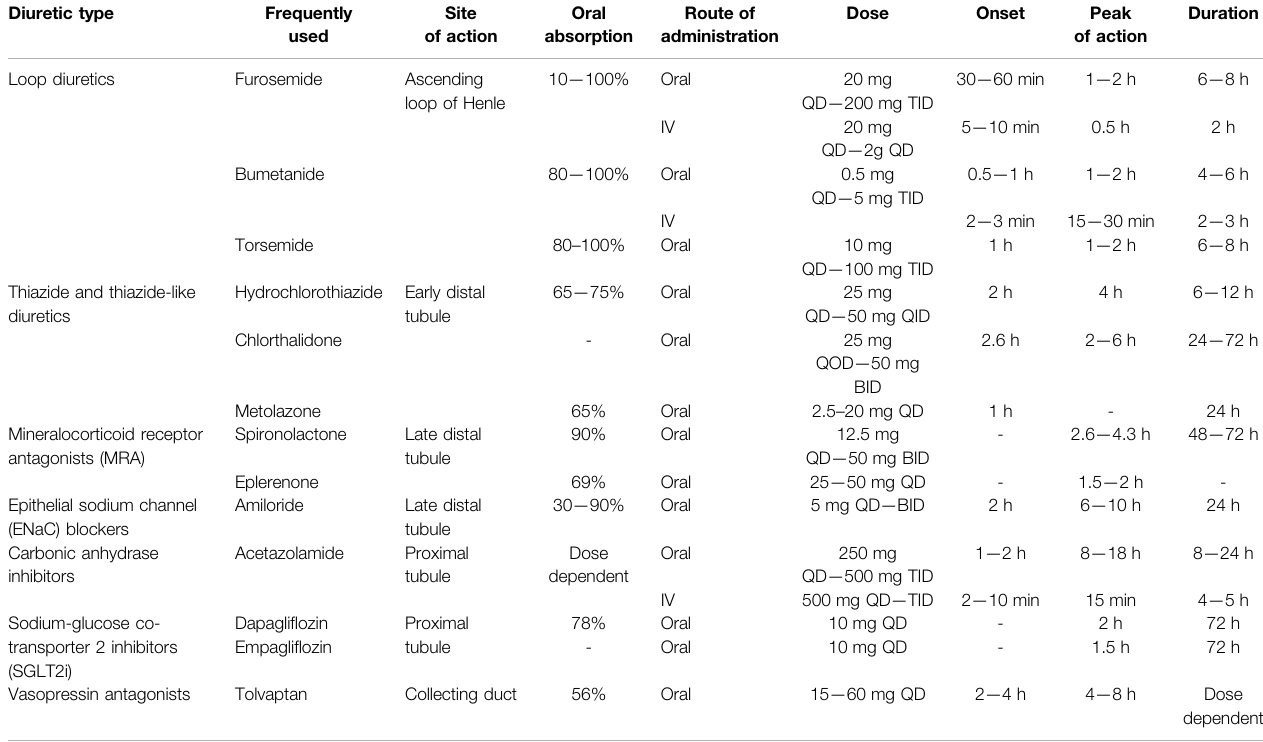
TABLE 1 | Most frequently used diuretics. Type, site of action, dose, absorption, onset, and duration of action. Diuretic